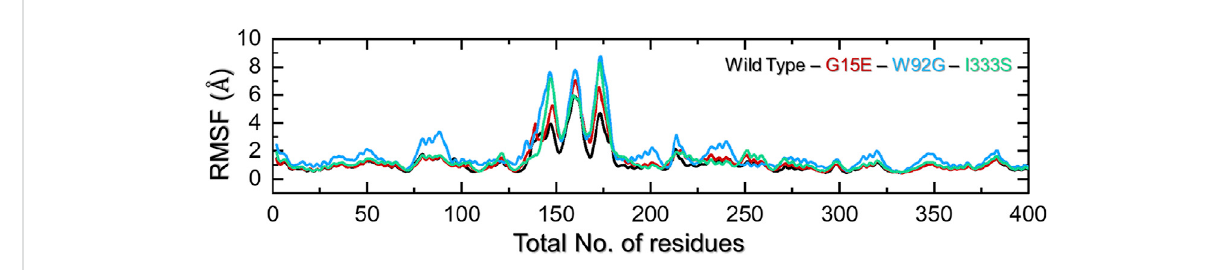
FIGURE 6 Residues ’ fl exibility analysis of the wild-type and mutant complexes. The x-axis represents time in total number of residues while the y-axis represent RMSF in (cid:1) A.